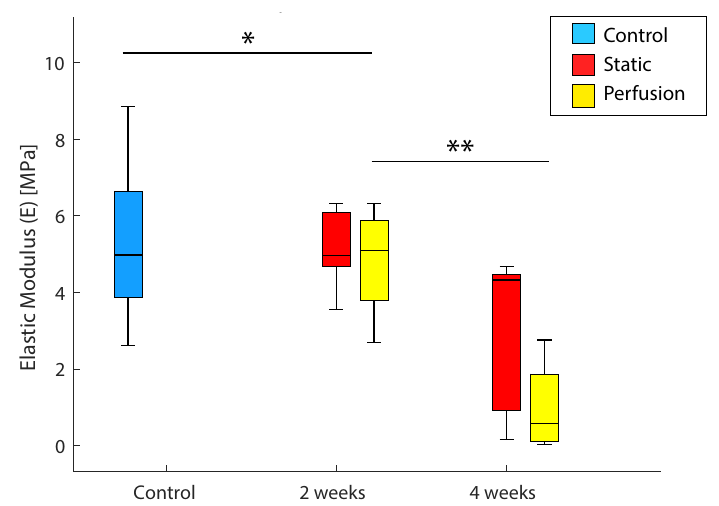
Figure 8. Compression elastic modulus variation (MPa) of samples after 2 and 4 weeks of incubation under static (red) and perfusion (yellow) conditions. Samples without incubation period were selected as control (blue). Statistical significance was considered as p -value < 0.05: * p -value = 0.0305 ( p < 0.05), ** p -value = 0.0048 ( p <